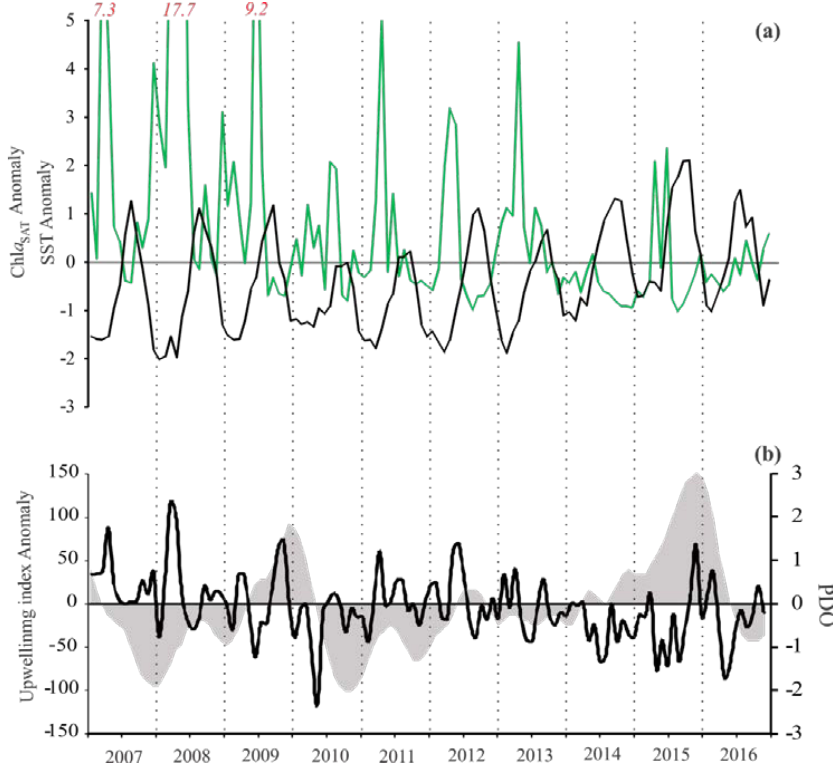
Figure 2. Time series of ( a ) MODIS Chl a (Chl a SAT ) (green line) and Sea Surface Temperature (SST) (black line) anomalies. Values off scale in Chl a SAT are indicated with red numbers. ( b ) Upwelling index anomaly (black line, unit m3.s −1 per 100 km of coastline) and Pacific Decemberadal Oscillation (PDO, gray area).